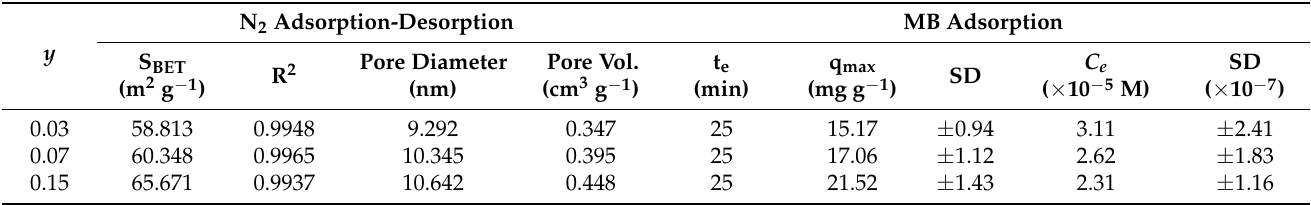
Table 3. Specific surface characteristics and dye adsorption efficiencies of BiFeVOx.y photocatalyst series.